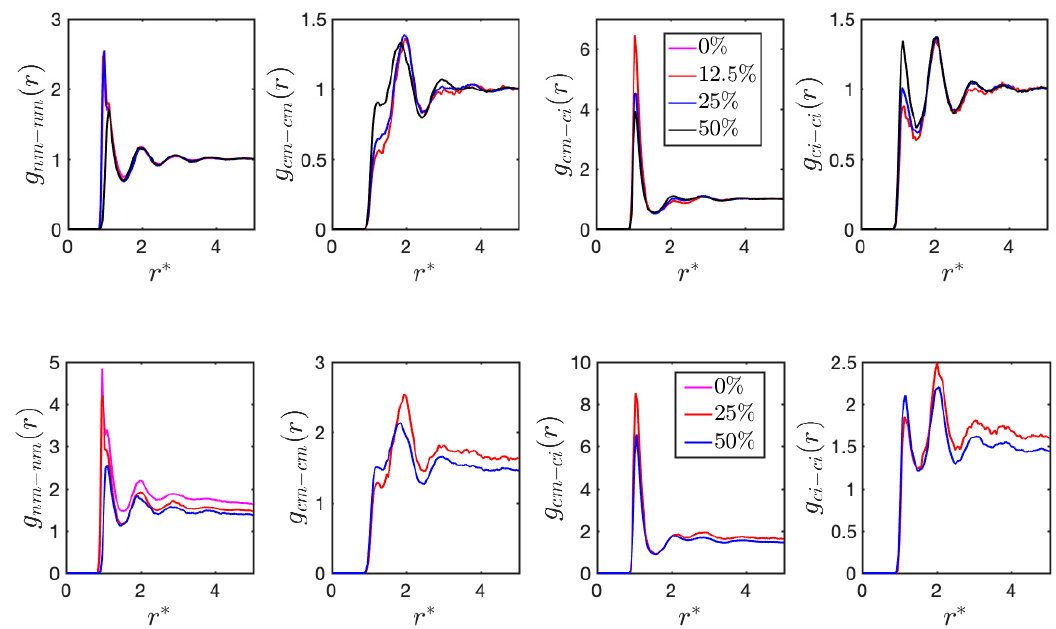
Figure 3. Radial distribution function of neutral monomer-neutral monomer ( g nm − nm ), charged monomer-charged monome g cm − cm , charged monomer-counterion g cm − ci , and counterion -counterion g ci − ci pair of (top panel) HPs and (bottom panel) di-BCPs at T * = 1.0.